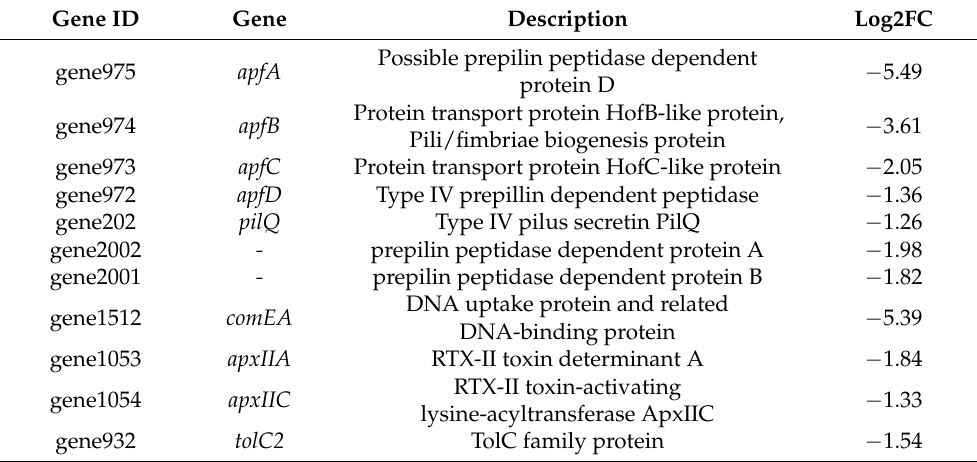
Table 2. DEGs related to biofilm